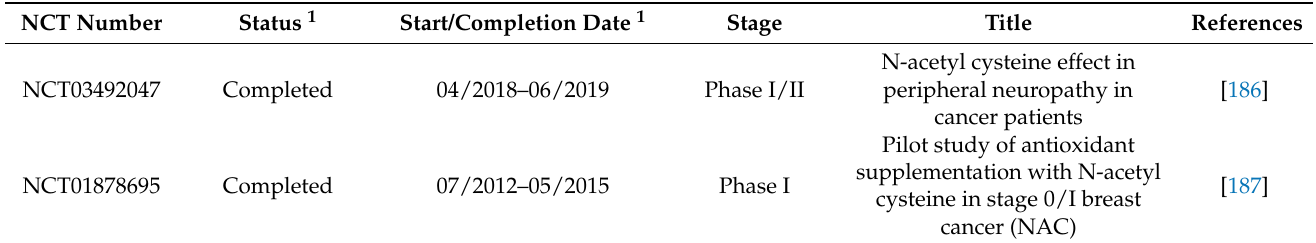
Table 11. Clinical trials with synthetic antioxidants in breast